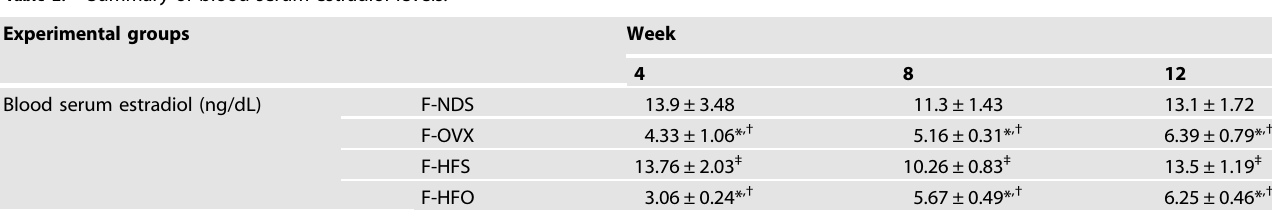
Table 2. Summary of blood serum estradiol levels.